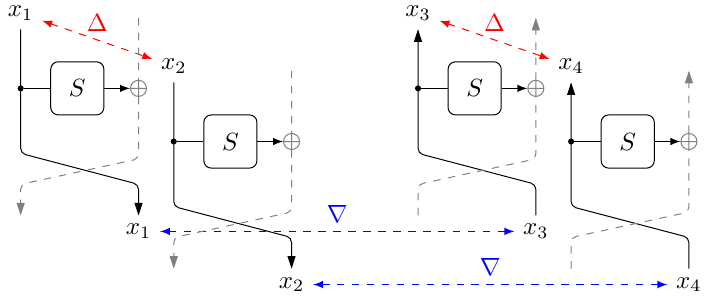
Figure 2: Differences of S-box at four sides of boomerang switch in Feistel